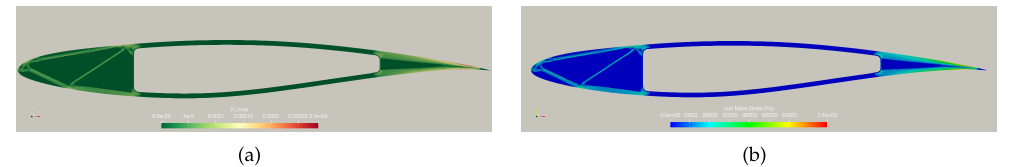
Figure 16. ( a ) Failure index distribution and ( b ) von Mises stress distribution for the topologically optimized structure of case 1.